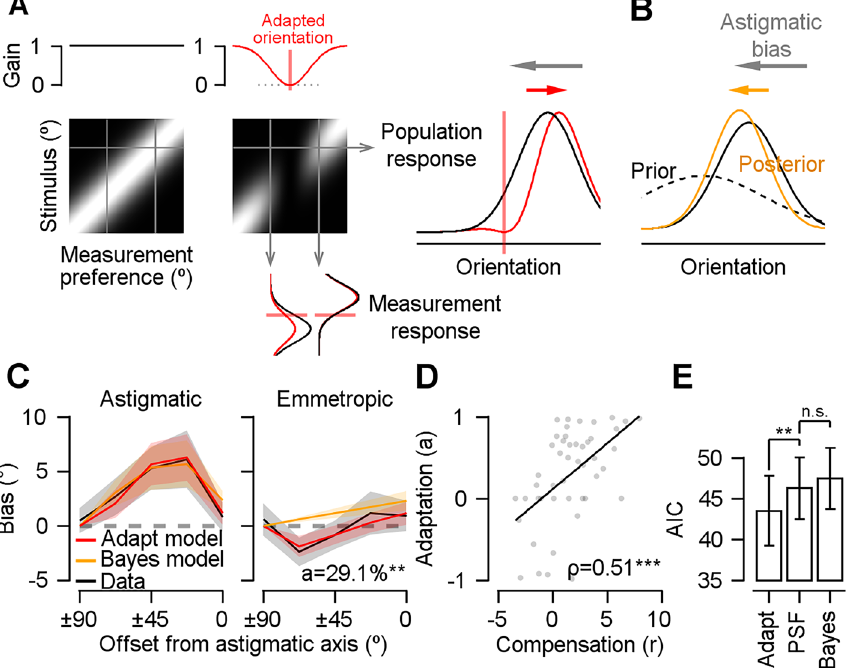
Figure 4. The result of the adaptation and the Bayesian model. ( A ) The response matrix of the adaptation model. The vertical axis represents the response of a single measurement to the various stimuli orientations, and the horizontal axis represents the population response to single stimulus orientation. The upper panels indicate each measurement’s gain function. A decrease in Gaussian shape gain around the adapted orientation results in the parametric reduction of each measurement’s response around the adapted orientation (lower panels). In population orientation tuning response, the reduction of gain around the adapted orientation causes the repulsive shift against the astigmatic bias (right panel). ( B ) In the Bayesian model, the prior expectation is built after long exposure to the biased distribution of astigmatism (dashed black line). Then, the outcome of perceptual inference, or posterior distribution (orange line), is shifted toward the prior expectation, conforming to the astigmatic bias. ( C ) Each model’s predictions for the perceptual bias in the astigmatic vision and the emmetropic vision condition (red: adaptation model; orange: Bayesian model) overlapped with the actual perceptual bias (black). The value a indicates the amount of gain–loss in percentage (** p < 0.01). The shaded areas indicate ± 2 SEM. ( D ) The relationship between the amount of gain loss and compensation in astigmatism. Rho indicates Spearman’s correlation coefficient (*** p < 0.001). The solid line indicates the result of linear regression. ( E ) The corrected Akaike’s Information Criteria was estimated from the predictions of the adaptation model (adapt), point spread function model (PSF), and Bayesian model (Bayes) on the emmetropic vision state. The error bars indicate ± 2 SEM (** p < 0.01; n.s., p >